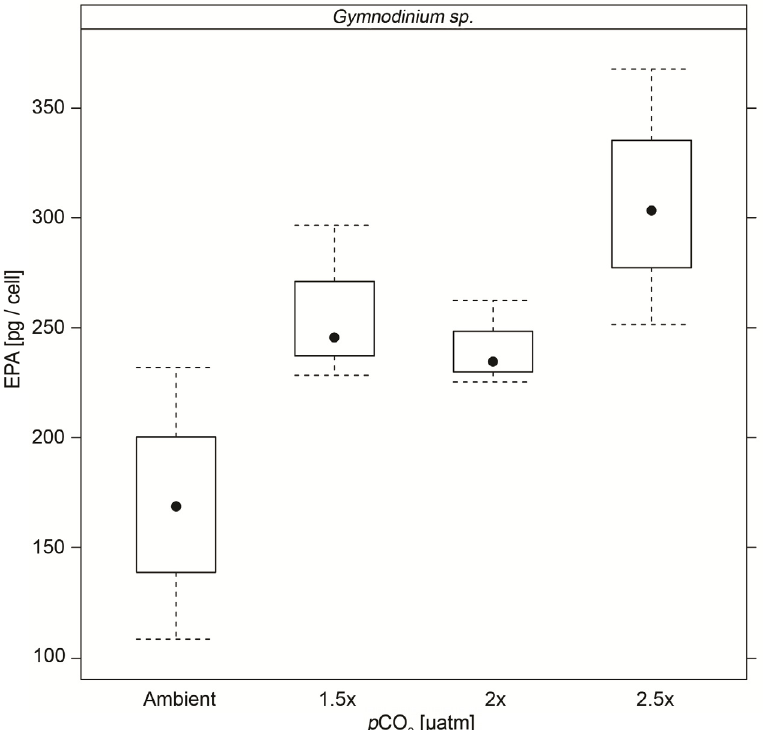
Figure 4. EPA content (pg/cell) with standard deviation of Gymnodinium sp. cultures under the different CO 2